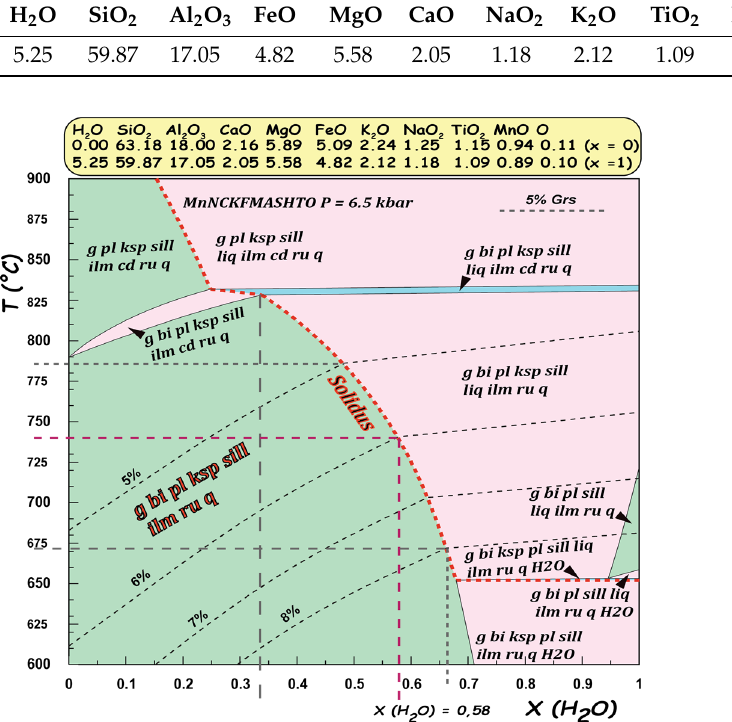
Figure 8. T-X H2O pseudosection calculated at 6.5 kbar in the MnNCKFMASHTO chemical system, with calculated compositional isopleths of the grossular (Grs) content of garnet used for determining the bulk H 2 O content. The observed syn-thermal peak assemblage (g bi pl ksp sill ilm ru q) is stable just above the solidus for X H2O values ranging from 0.34 to 0.66 mol.%. Red dashed line: solidus. Pink dashed line: selected X H2O (0.58) value. Table 2. Representative microprobe analyses of principal metamorphic minerals from the migmatitic paragneisses of the Filali unit. The amount of ferric iron was calculated from stoichiometric constraints using the program AX. Inc = inclusion.